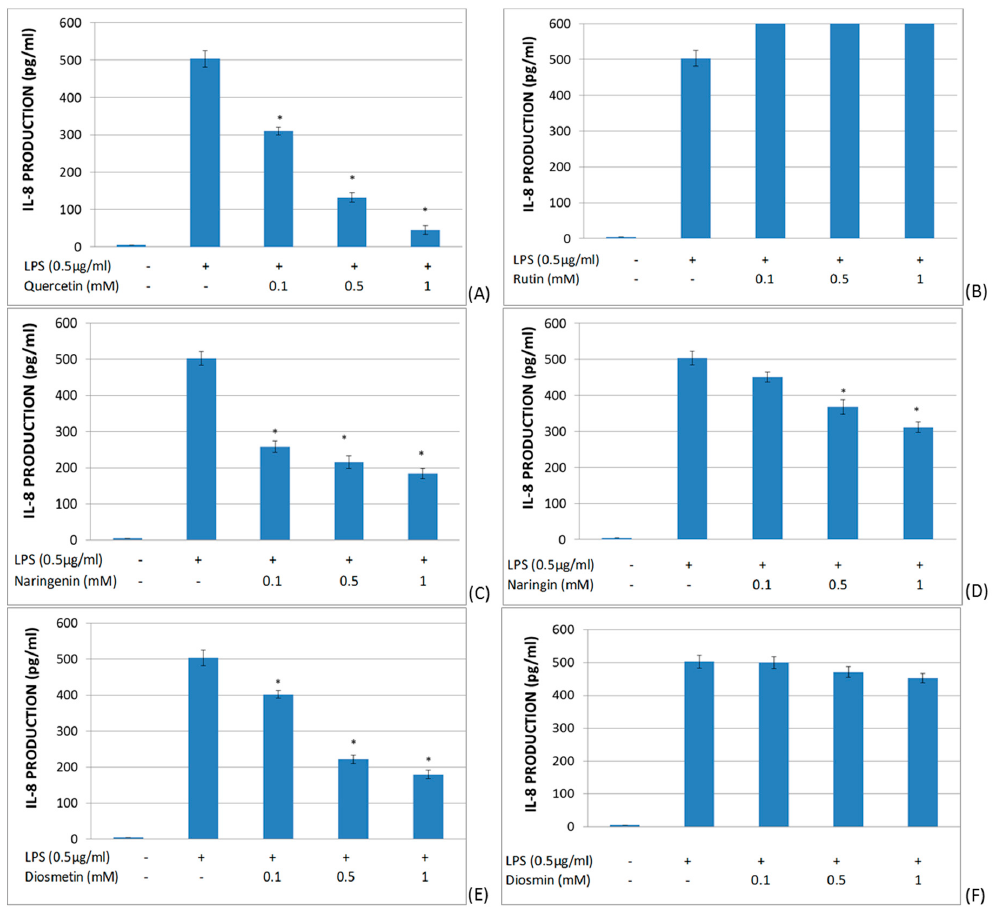
Figure 5. Effects of different flavonoids on the production of IL-8 in LPS-stimulated (0.5 μ g/mL) whole blood after 6 h of culture. The different panels show the results of the effects of quercetin ( A ), rutin ( B ), naringenin ( C ), naringin ( D ), diosmetin ( E ), and diosmin ( F ). All data are expressed as the mean (top segment of the rectangles) ± SEM (vertical segment) of thirty independent experiments. * p < 0.05: significantly different when compared to the LPS control.